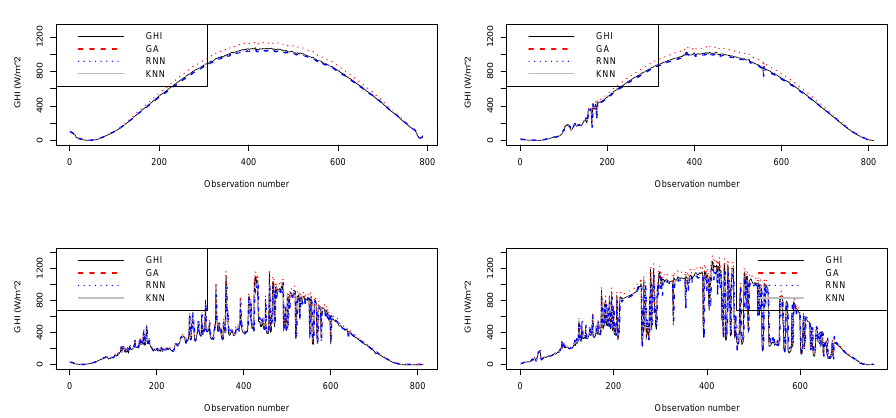
Figure 10. GHI superimposed with GA, RNN, and KNN forecasts Top panels: Clear sky days Bottom panels: Cloudy